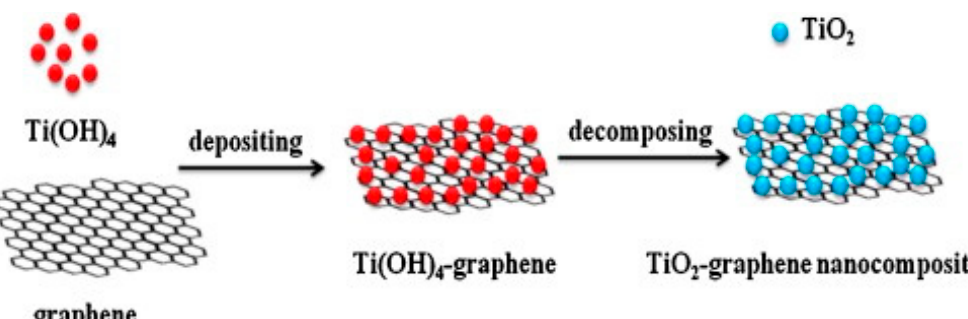
Figure 6. A schematic representation of the ST-based synthesis of TiO 2 /G nanocomposites. Reprinted with permission from reference [115]. Copyright 2012 Elsevier. with permission from reference [115]. Copyright 2012